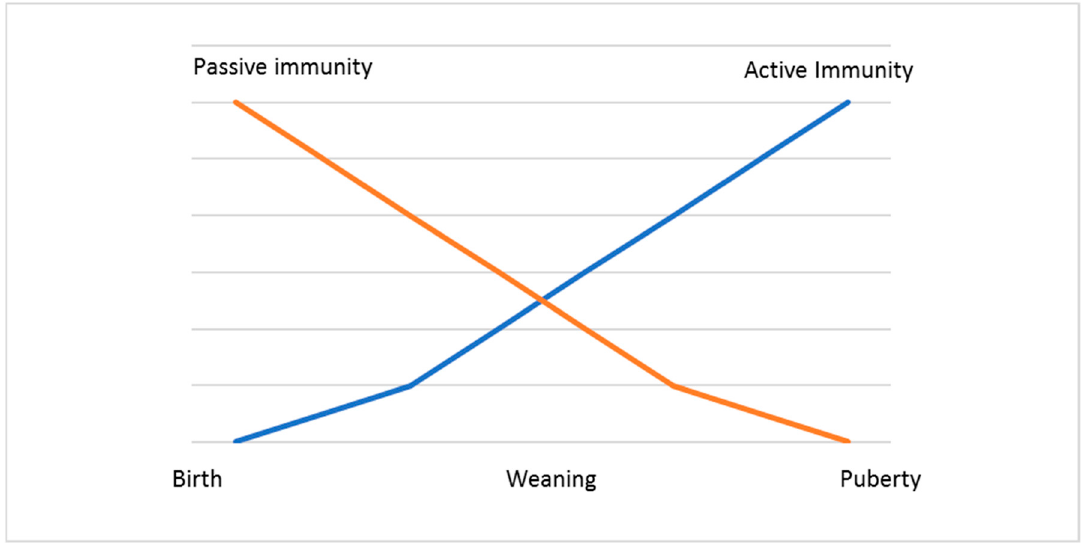
Figure 2. Development of the immune response in calves.